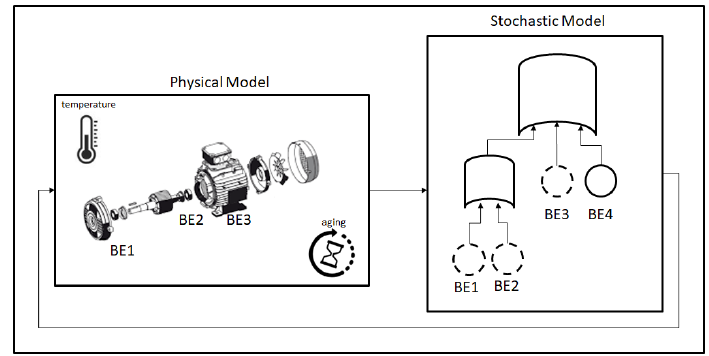
Figure 9. The SHyFTA model of an electric motor.